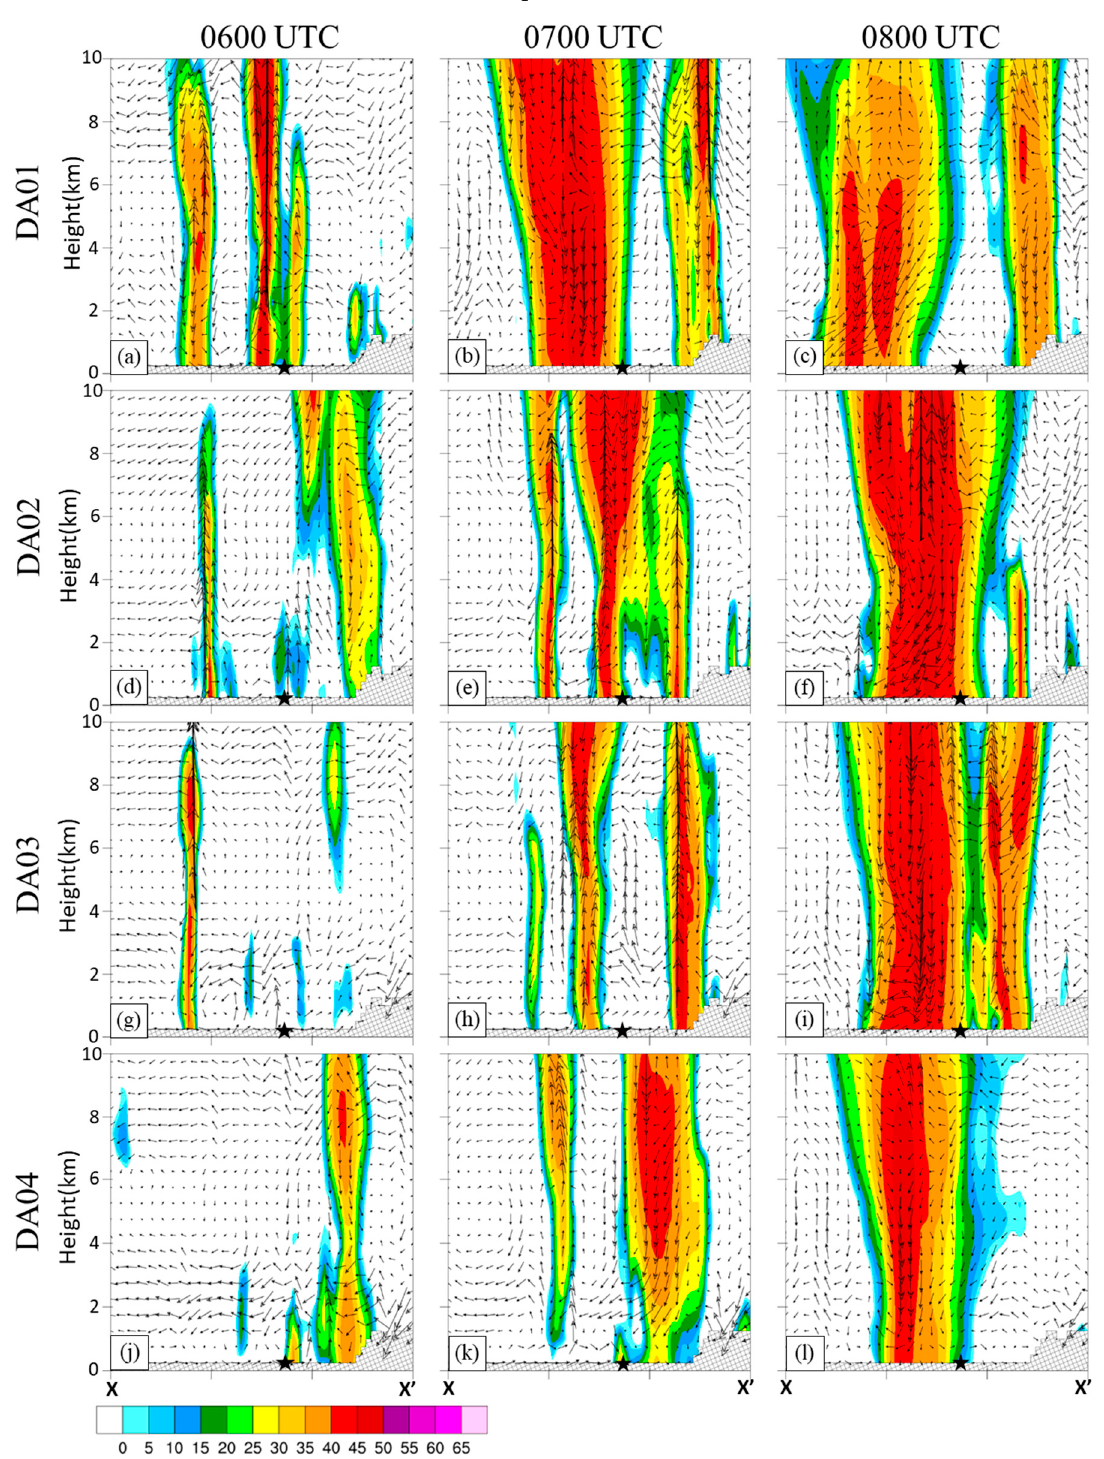
Figure 12. Vertical cross section of maximum reflectivity and horizontal wind vector from 0600 to 0800 UTC (1400 to 1600 LST) on 5 August 2018, ( a – c ) DA01; ( d – f ) DA02; ( g – i ) DA03; ( j – l ) DA04 simulations along the northwest-to-southeast plane (from x to x (cid:48) ) depicted in Figure 10. The title of each chart showed the accurate location of reflectivity we selected and the approximate location of Pingtung Air Force Base was depicted as black